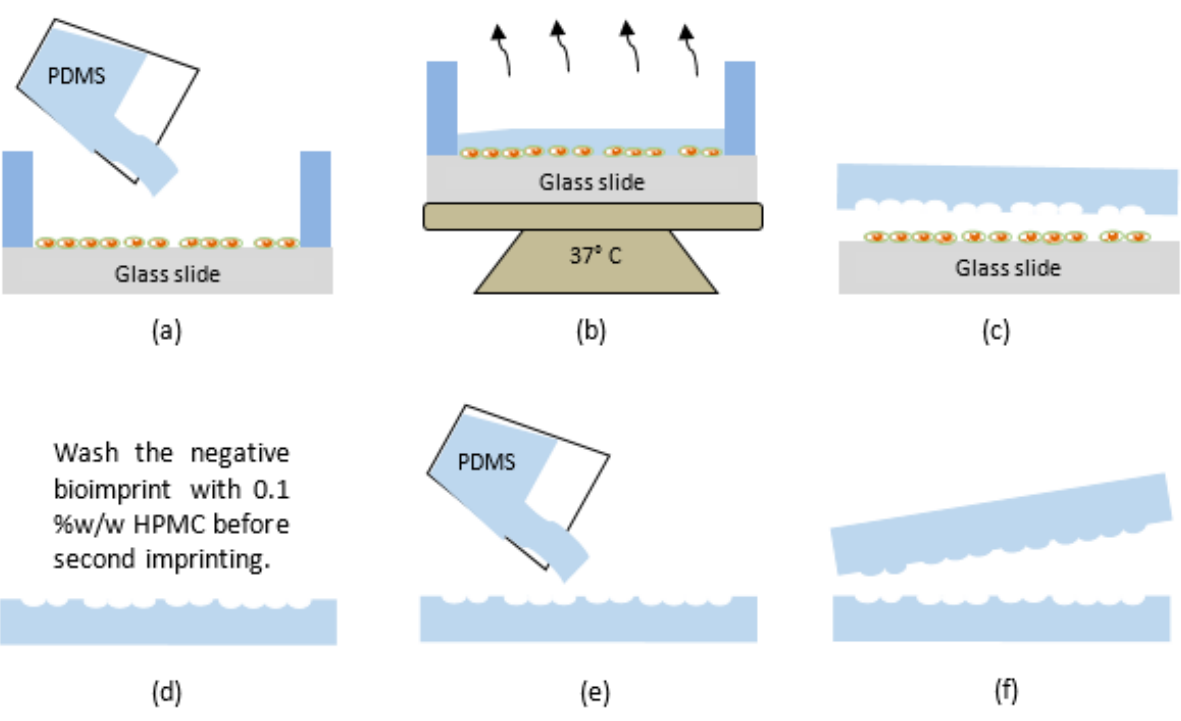
Figure 1. Schematic diagram of negative and positive PDMS bioimprint fabrication process: ( a ) liquid PDMS is dispensed on fixed cells, ( b ) the polymer is cured at 37 °C for 12 h, ( c ) negative PDMS mould is carefully peeled off from fixed cells and post-baked at 80 °C for two hours to complete polymerization, ( d ) negative PDMS mould is washed with 0.1% w / w HPMC for 10 min, ( e ) liquid PDMS is poured on the negative mould, then the curing process follows as in in step ( b ), and ( f ) the positive bioimprint PDMS is peeled off from negative PDMS bioimprint mould and hard baked at 80 °C for two hours.